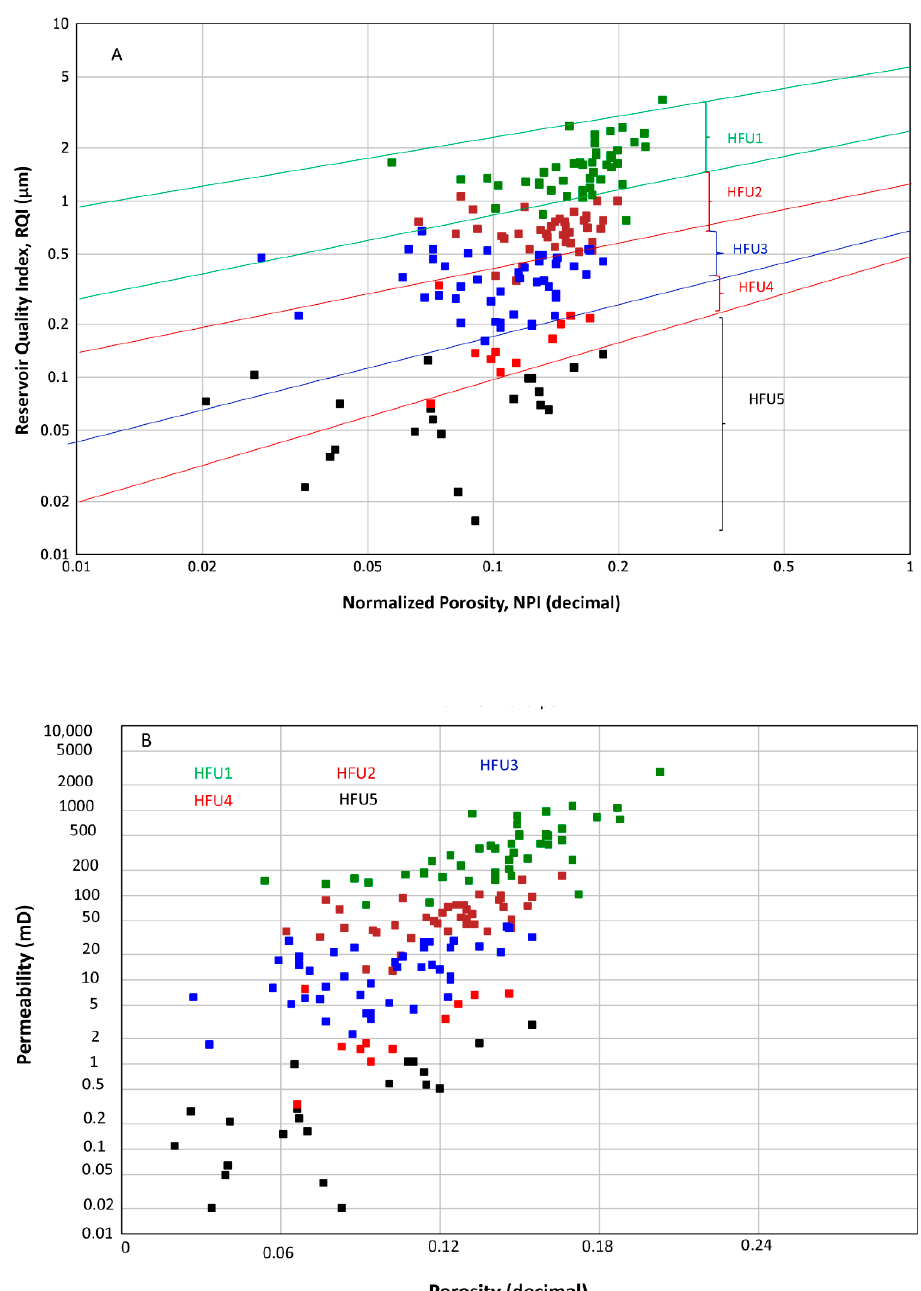
Figure 4. ( A ) Calculated FZI used to identify different HFUs from RQI versus NPI. ( B ) Permeability versus porosity plot showing different hydraulic flow units, HFU